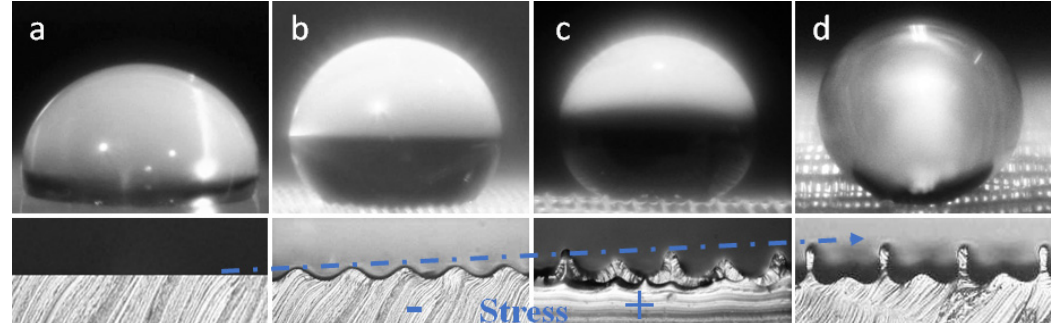
Figure 3. Lateral view images of water droplet on the various surfaces. ( a ) Smooth PDMS ( θ e = 110°); ( b ) sinusoidal wrinkled PDMS ( δ = 33% and θ w = 135°); ( c ) two peak amplitudes of wrinkle ( δ = 45% and θ w = 145°); and ( d ) structured PDMS ( δ = 64% and θ c ~ 180°).